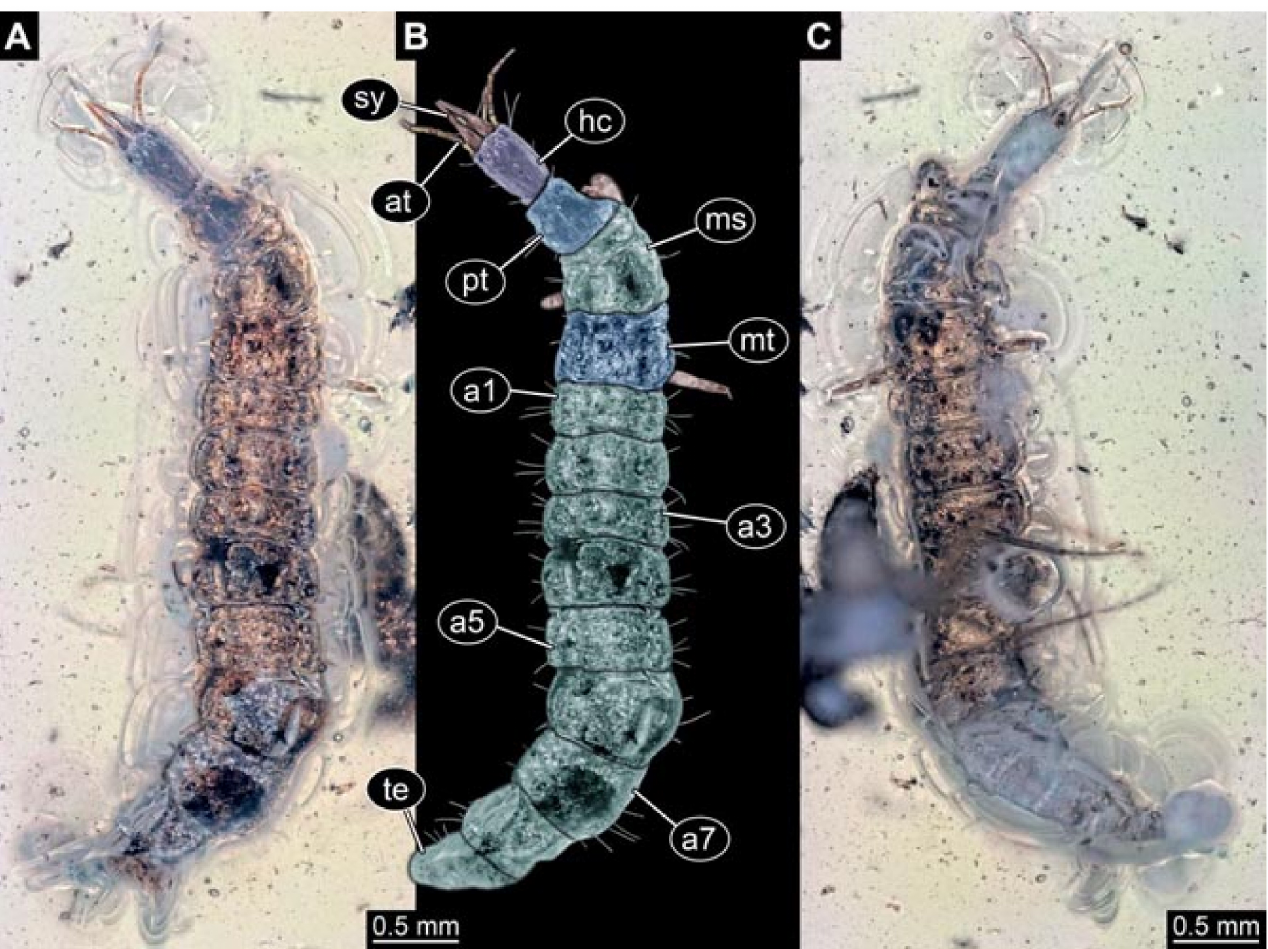
Figure 1. Specimen 5803 (CCHH 1270-1, now SDEI Lep-103564); Baltic amber. ( A ) Dorsal view. ( B ) Dorsal view, colour marked. ( C ) Ventral view. Abbreviations: a1–a7 = abdomen segments 1–7; at = antenna; hc = head capsule; ms = mesothorax; mt = metathorax; pt = prothorax; sy = stylet; te = trunk